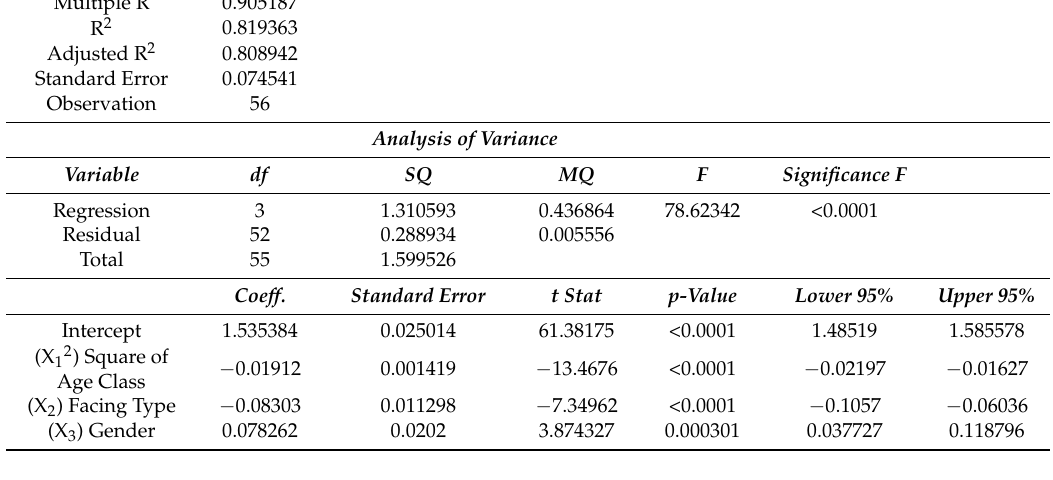
Table 5. Global model: regression statistics and ANOVA.